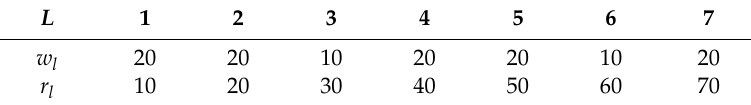
Table 4. Lot data for Example 2.